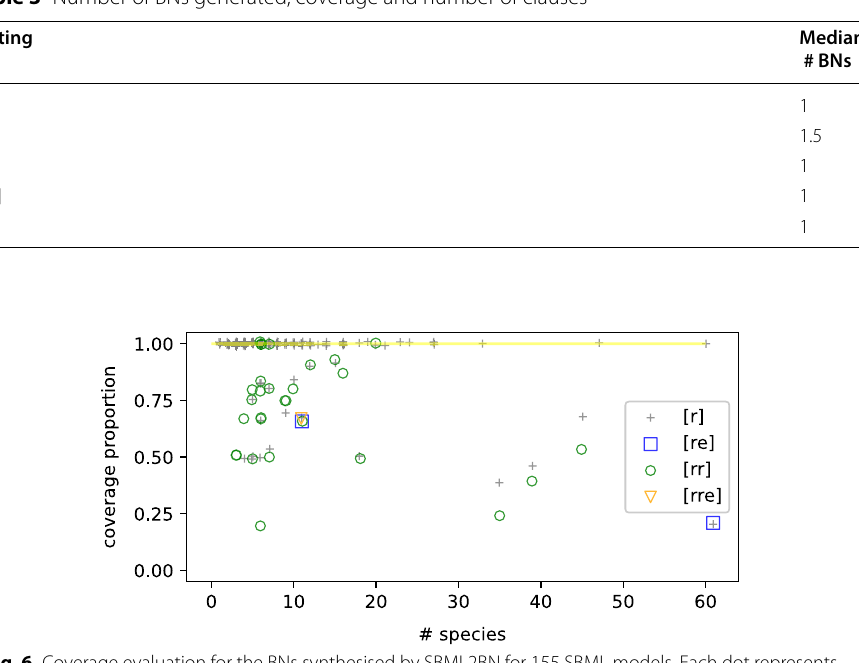
Fig. 6 Coverage evaluation for the BNs synthesised by SBML2BN for 155 SBML models. Each dot represents the set of BNs returned for a given SBML model in a given setting. Its coordinates are the coverage ratio median (ordinate) and the number of species of the SBML model (abscissa). The yellow line shows where the dots are when the pipeline only returns BNs with a perfect coverage. The points are slightly jittered on x and y axes with a Gaussian noise of variance 0.2 and 0.02 respectively to ensure